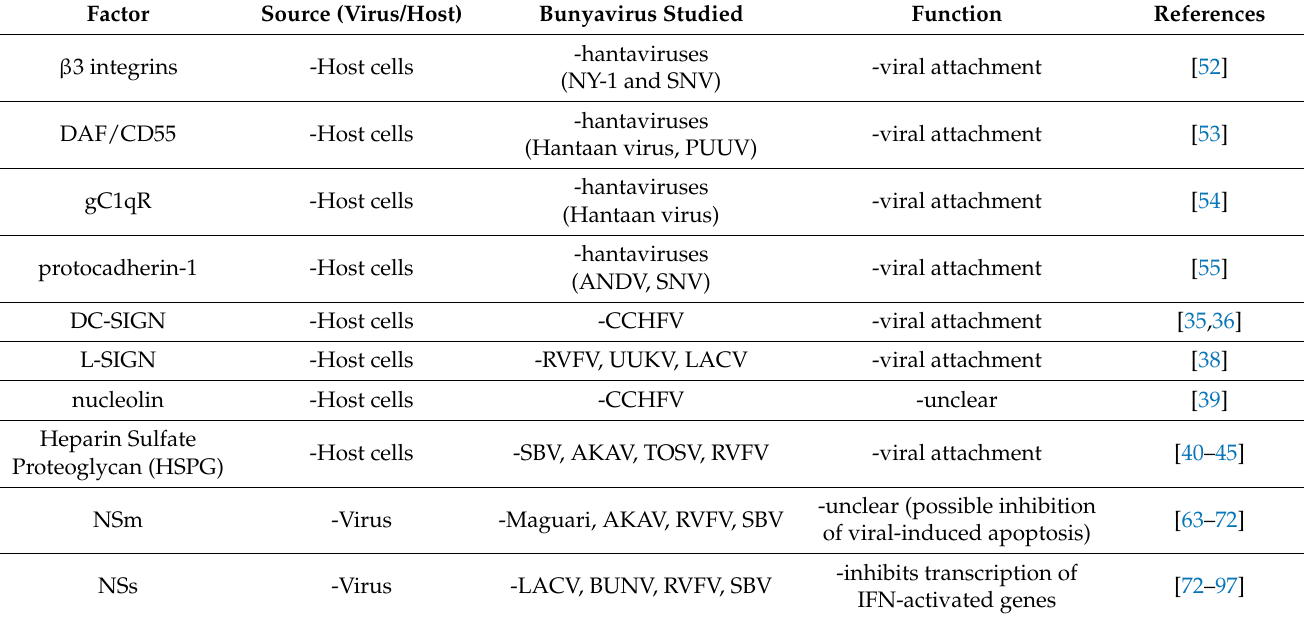
Table 1. Selected Viral/Host Factors That Affect Viral Infection and